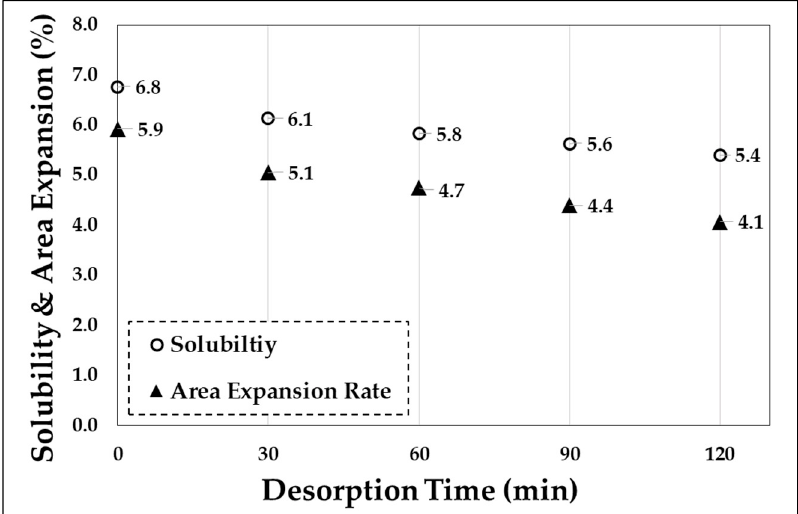
Figure 14. Sorption rate and area expansion based on the desorption time.